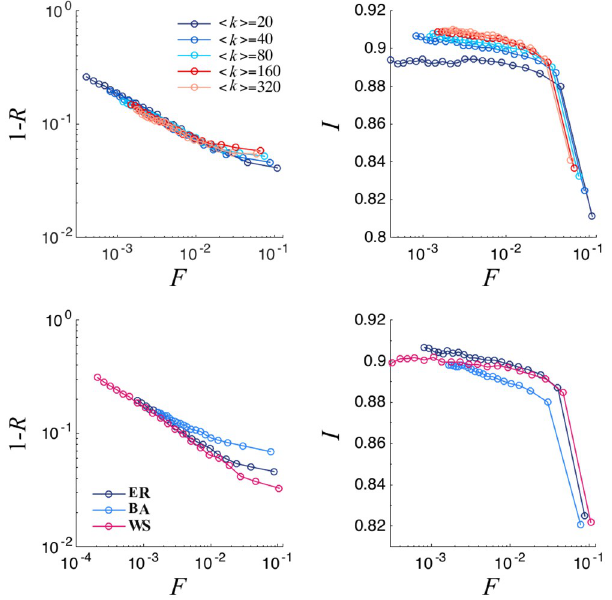
Fig 5. Top: Logarithmic plot of 1 − R versus normalized committee size (left) and Mean Committee Integrity as a function of normalized committee size (right) for different values of h k i . Bottom: Logarithmic plot of 1 − R versus normalized committee size (left) and Mean Committee Integrity as a function of normalized committee size (right) for different network topologies. We consider a Erdo¨s-Re´nyi network with N are averaged over 100 different